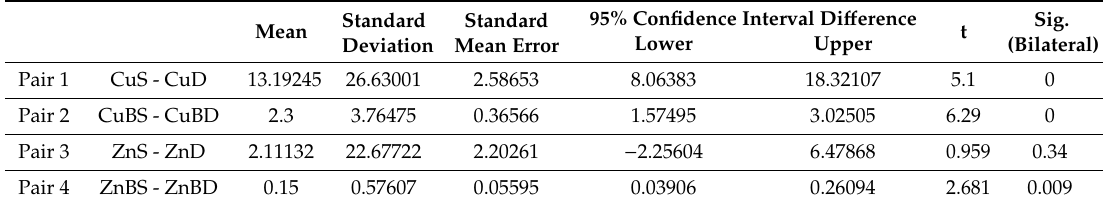
Table 3. Mean di ff erences between S and D total and bioavailable (B) concentrations of Cu and Zn.